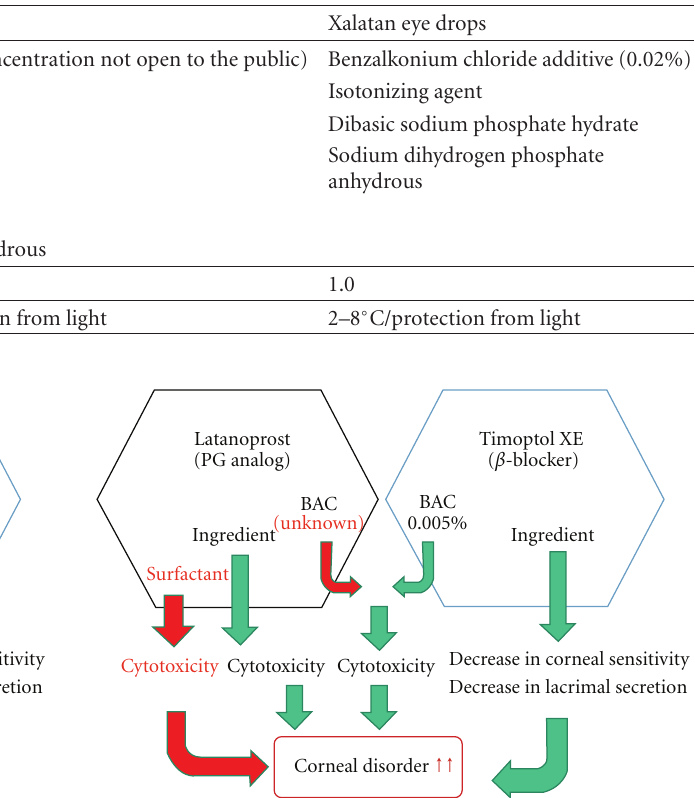
Figure 3: Although corneal disorder can be induced by the cyto- toxicity of the main component and BAC in Xalatan eye drops, the cytotoxicity of BAC in Timoptol XE eye drops, or decreases in corneal sensitivity and lacrimal secretion due to the main compo- nent of the latter, no corneal disorder developed in this patient.